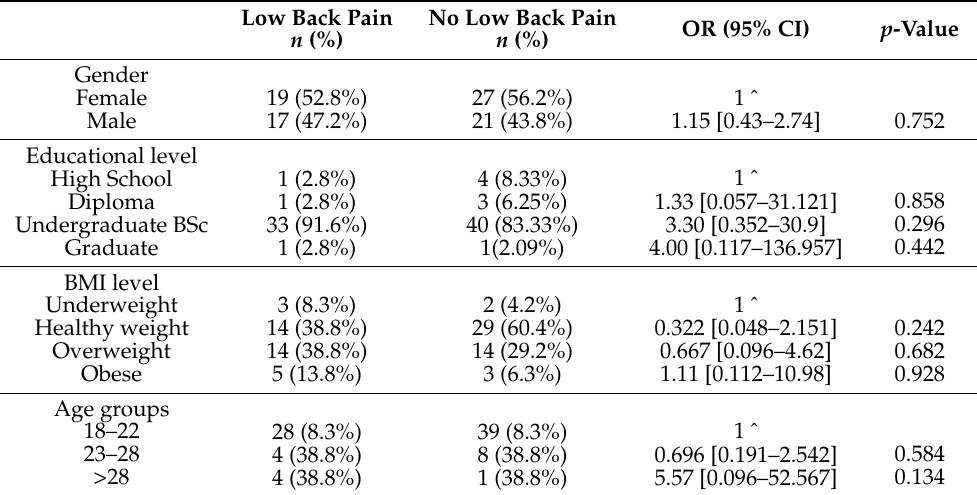
Table 6. Association between low back pain and